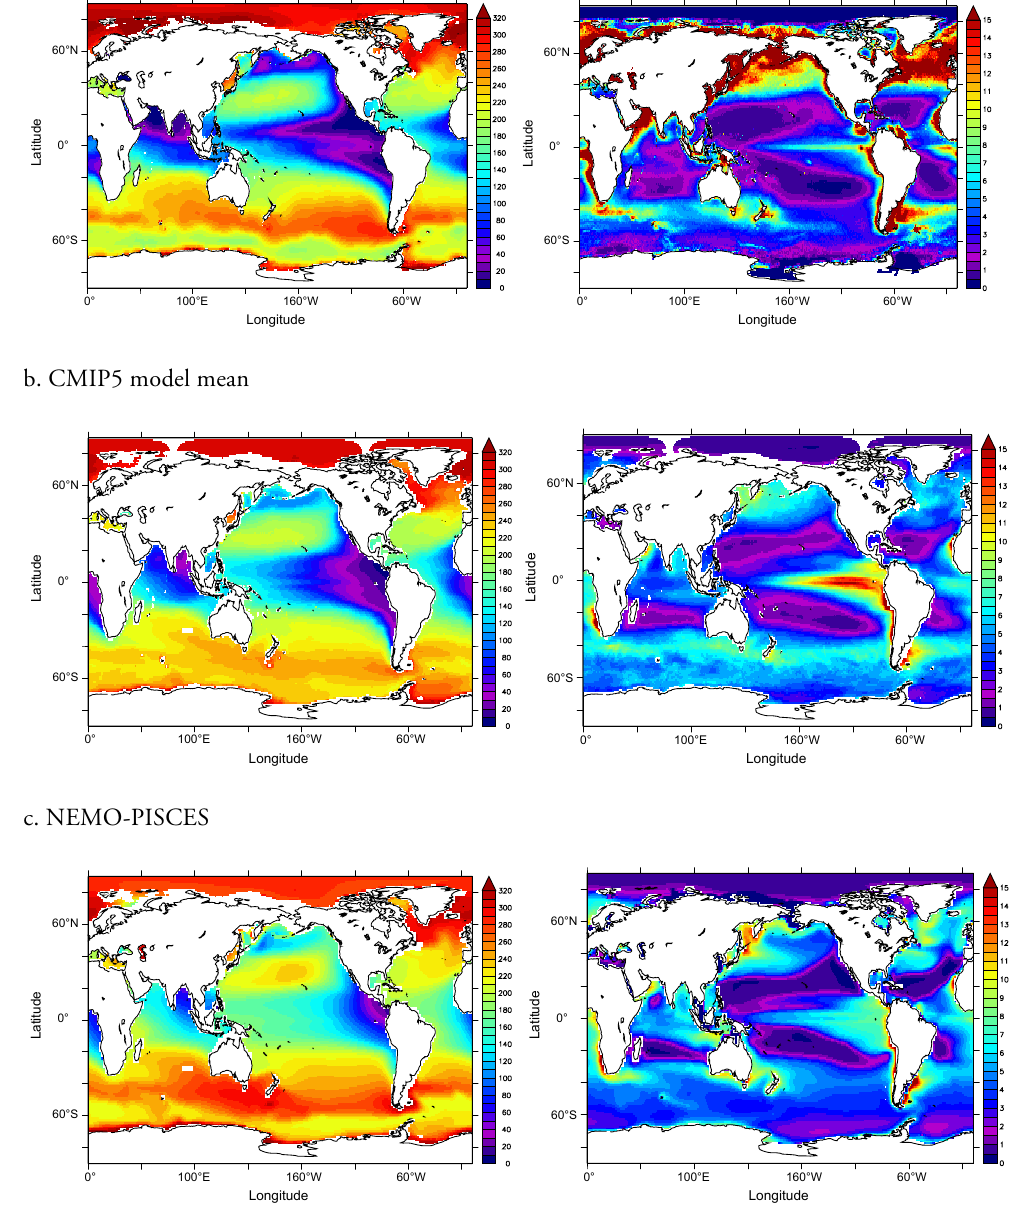
Figure 9. Averaged O 2 concentration between 200 and 600m depth (inµmolL − 1 ) (left) and export of carbon (in mmolCm − 2 d − 1 ) (right) in (a) WOA2005* and Dunne et al. (2007), (b) CMIP5 model mean historical simulations over the 1985–2005 time period and (c) NEMO- PISCES for the present 1985–2005 time